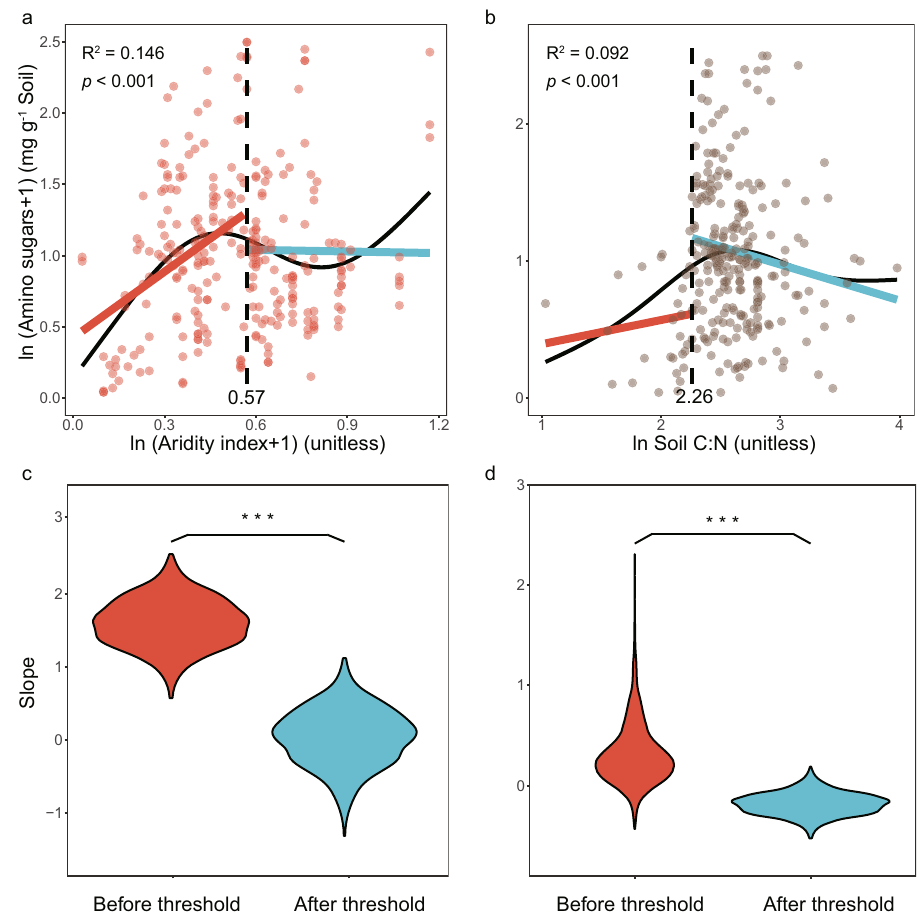
Fig. 3 Models of amino sugar responses to aridity index and soil C:N ratio. a, b Nonlinear responses of amino sugars to aridity index and soil C : N ratio. c , d Differences of predicted values of variables under aridity and soil C:N ratio thresholds. Data for each variable ( a , b ) are log-transformed. a , b Black, red, and blue solid lines represent the smoothed trendline fi tted by the general additive model (GAM), and the linear fi tting on the left and right sides of each threshold, respectively. Black numbers and vertical dashed lines describe the identi fi ed threshold. Violin graphs ( c , d ) show the bootstrap predictions for each variable on each side of each threshold (red plots: regression before the threshold; blue plots: regression after the threshold). Three asterisks indicate a signi fi cant difference according to the Mann – Whitney U -test before and after the threshold at p < 0.001.